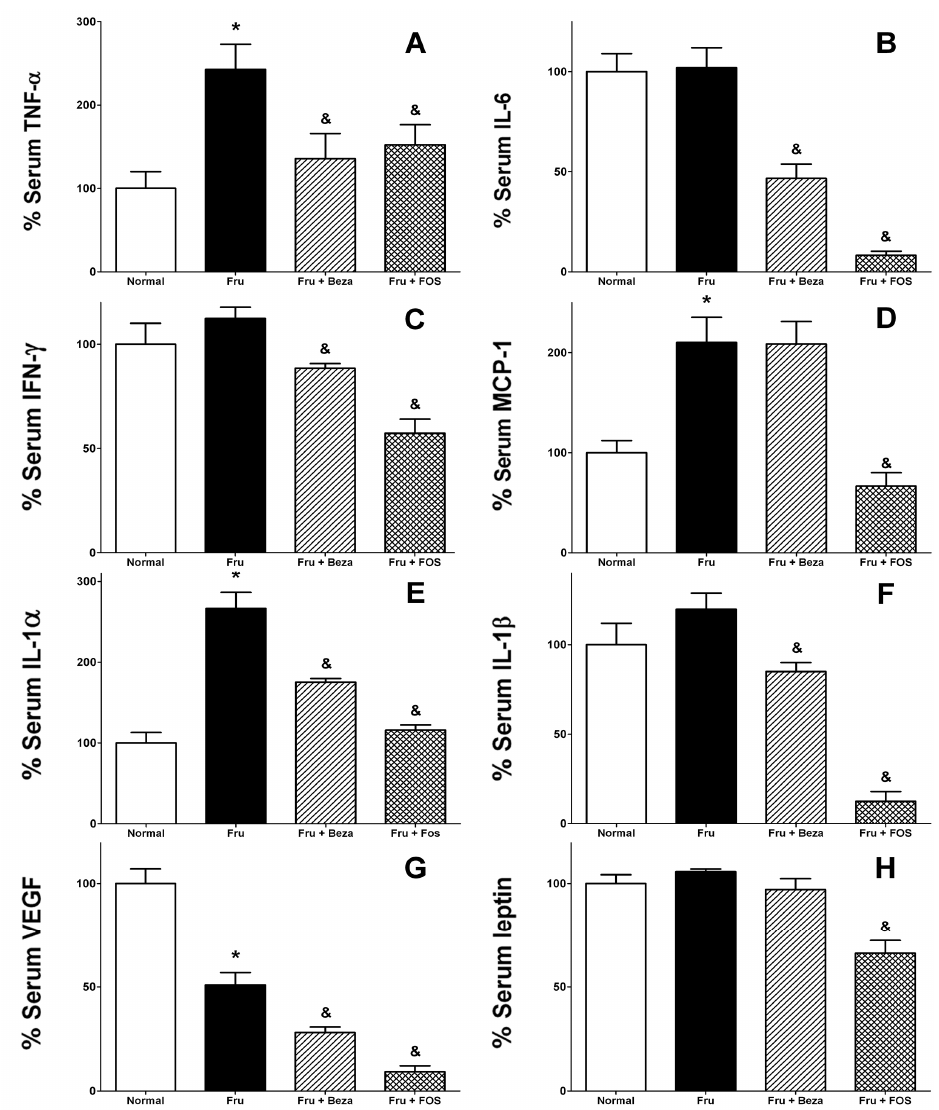
Figure 1. Effect of daily administration of FOS fraction from P. decompositum on inflammatory cytokines in male Wistar rats with 24 weeks fructose feeding ( A ) TNF- α ; ( B ) IL-6; ( C ) IFN- γ ; ( D ) MCP-1; ( E ) IL-1 α ; ( F ) IL-1 β ; (G) VEGF; ( H ) leptin, Mean ± S.E.M. (n = 6). * Statistically significant compared with the normal group; statistically significant compared to the group treated with Fru ( p < 0.05). Normal: normal rats without treatment; FRU: rats treated with high fructose; Fru + Beza: obese rats treated with bezafibrate; Fru + FOS: obese rats treated with